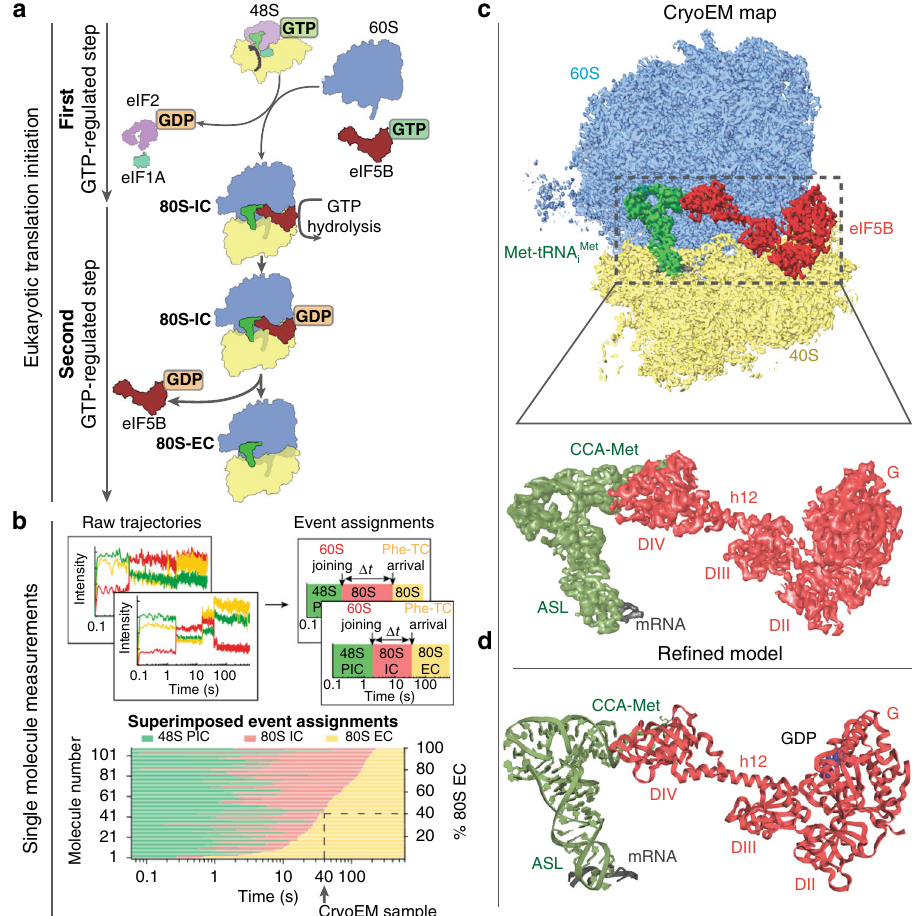
Fig. 1 Cryo-EM sample preparation guided by single-molecule fl uorescence data and overall architecture. a Overview of translation initiation in eukaryotes. Two steps, regulated by GTPases eIF2 and eIF5B control the delivery of Met-tRNA i Met . b Cryo-EM samples were prepared and froze at the timepoint 40 s after mixing 48S PICs, eIF5B:GTP, and 60S. At this timepoint, ~40% of the total 80S particles are expected to be 80S EC, while the other ~60% are 80S IC with eIF5B-bound, as demonstrated by our previous single-molecule fl uorescence data (Supplementary Fig. 1) 11 . c Overview of the fi nal cryo-EM map obtained after maximum likelihood classi fi cations in Relion 44 . Large subunit (60S) is colored in blue, small subunit (40S) yellow, Met- tRNA i Met green, mRNA gray, and eIF5B red. Bottom, details of the local map obtained for Met-tRNA i Met , mRNA, and eIF5B. Domain IV (DIV) of eIF5B is in close contact with the acceptor stem of Met-tRNA i Met . d Stereochemically re fi ned models for Met-tRNA i Met , mRNA, and eIF5B with components